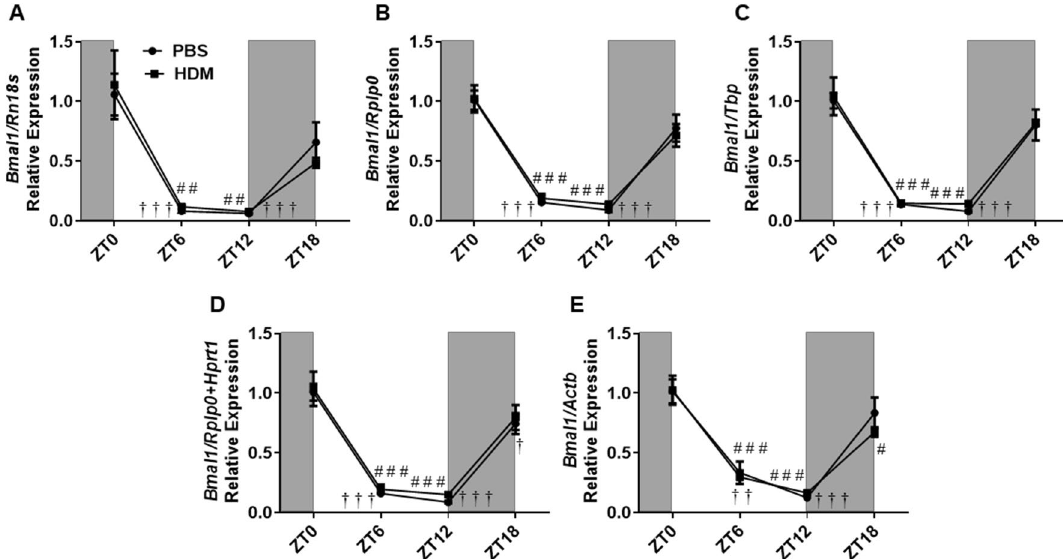
Figure 5. Bmal1 gene relative expression in HDM and PBS exposed mouse lung and data normalized with different reference genes. ( A ) Rn18s , ( B ) Rplp0 , ( C ) Tbp , ( D ) Rplp0 + Hprt1 and ( E ) Actb . Line graphs showing the relative expression of the Bmal1 gene in both HDM versus PBS group. White and gray areas in the graph represents the light and dark cycle, respectively. Symbols † and # represent the statistical significance in temporal expression of Bmal1 in the PBS and HDM group respectively at the marked time point when compared to the baseline (ZT0). Data are shown as mean ± SEM (n = 4/group; † P < 0.05, †† P < 0.01, ††† P < 0.001, compared to ZT0 PBS; # P < 0.05, # # P < 0.01, # # # P < 0.001, compared to ZT0